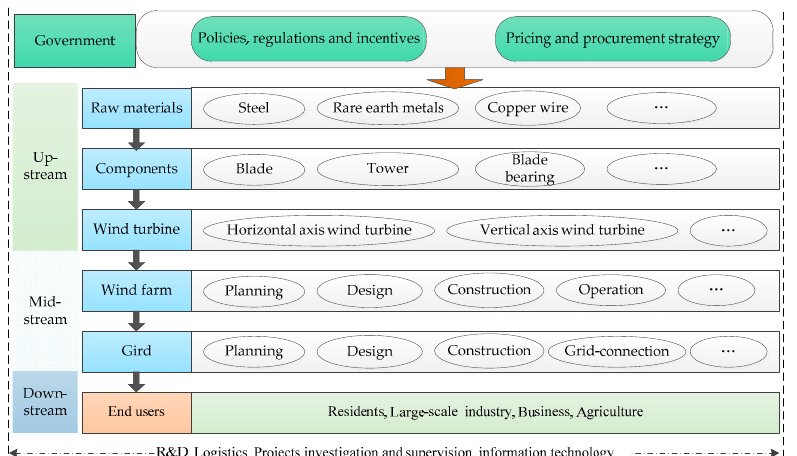
Figure 1. Structure of wind power industry chain.